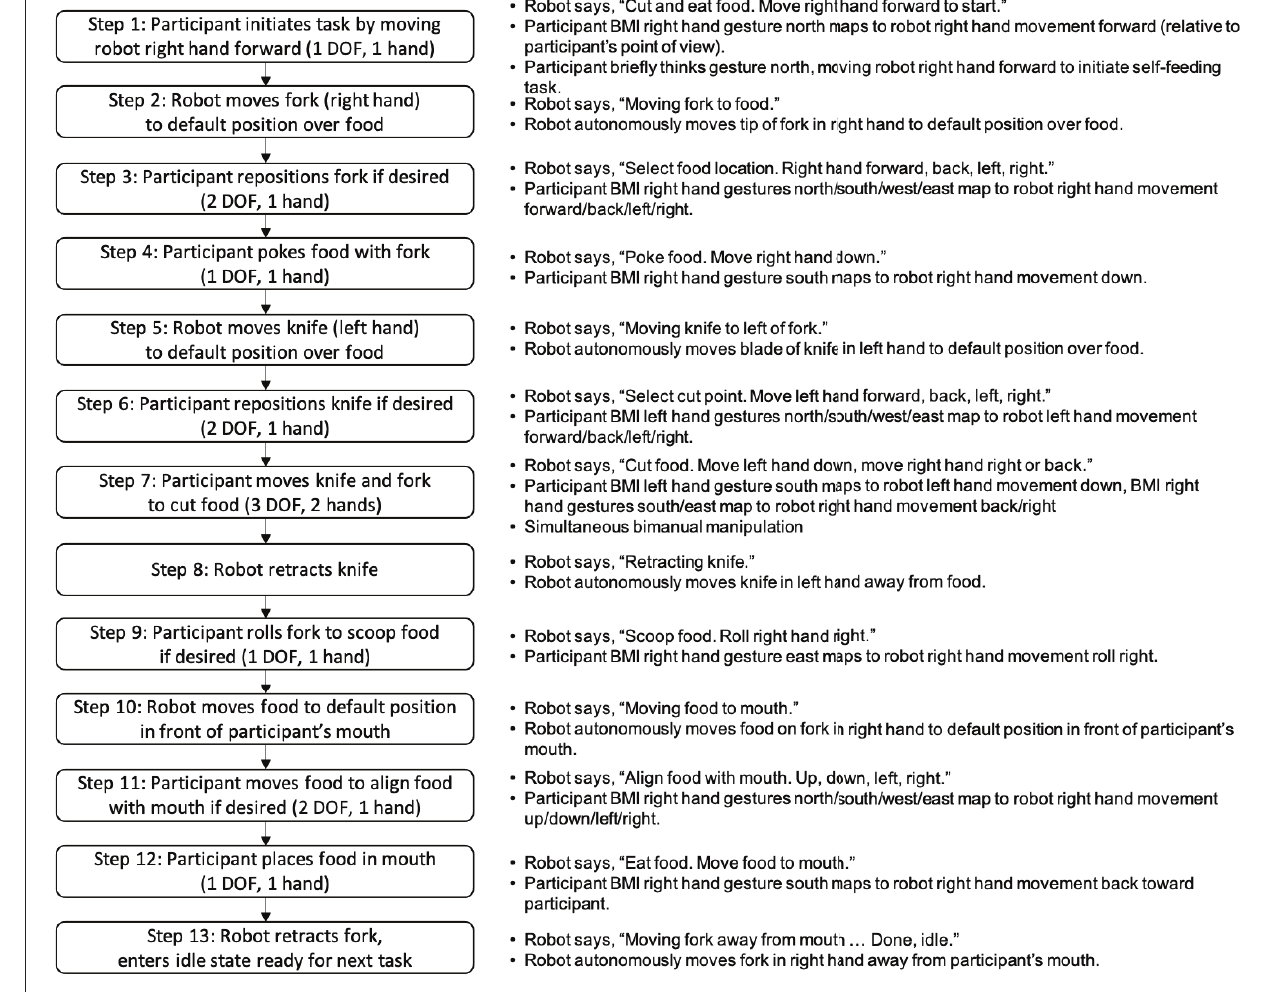
FIGURE 2 | Bimanual self-feeding task flowchart. The collaborative shared control strategy enables the participant to control a minimum set of DOFs while still maximizing task